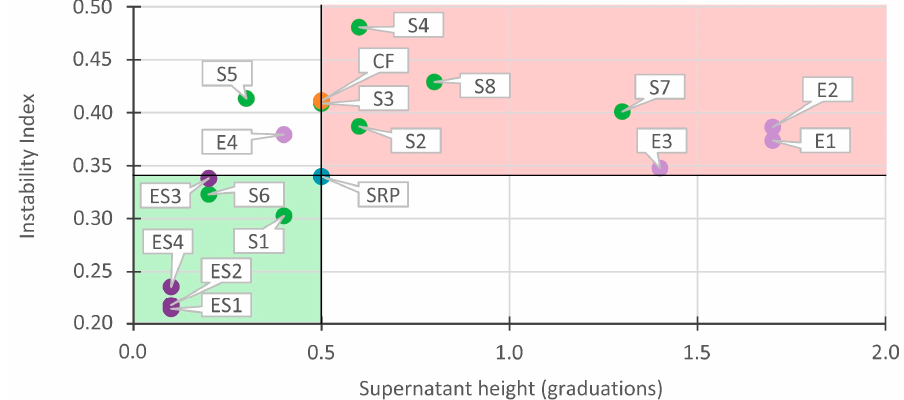
Figure 9. Correlation between the instability index and supernatant height in SRP with 1% of